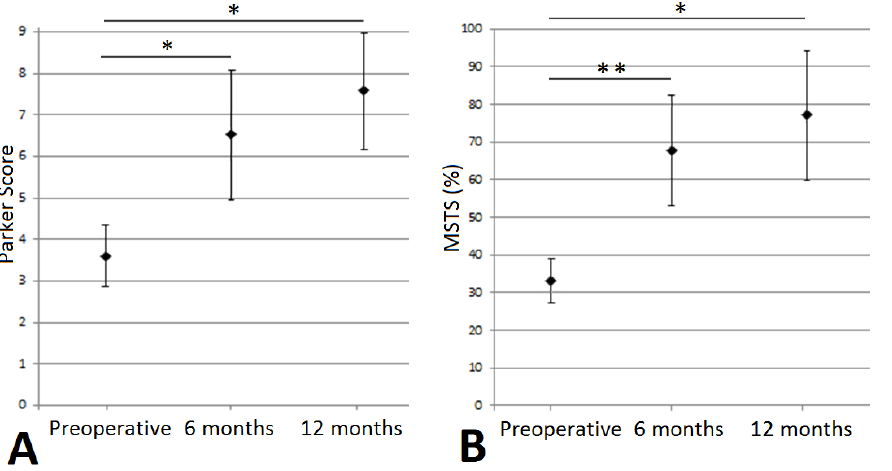
to preoperatively (32.2 ± 16.2) (Figure 3B) (Table 1). There was no significant difference between postoperative scores at 6 and 12 months ( p = 0.175).